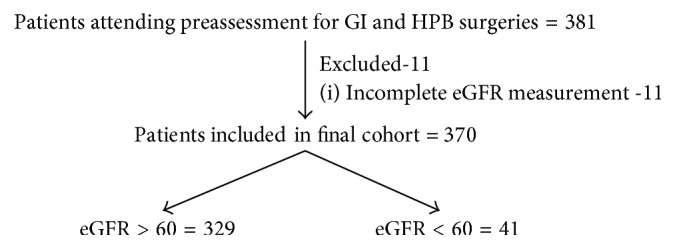
Flow diagram of included patients.